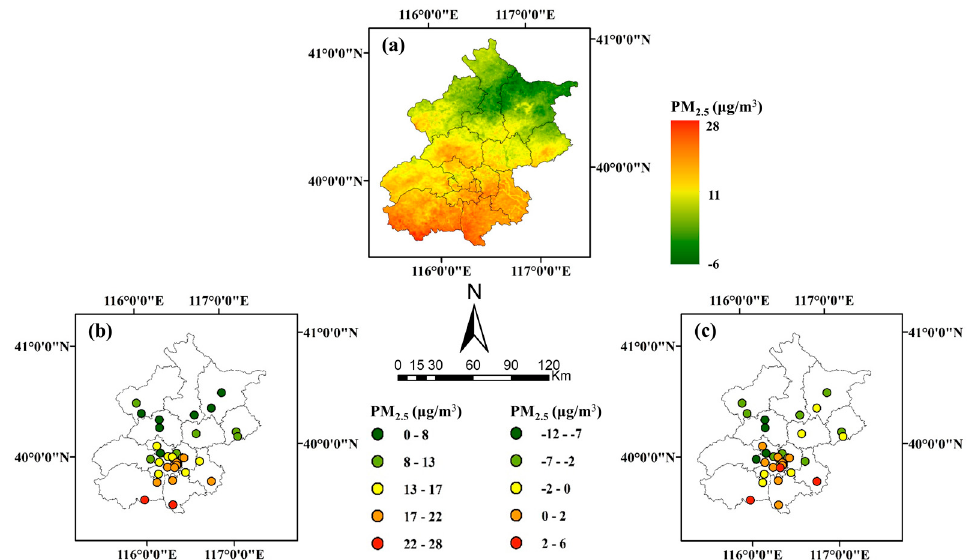
Figure 9. Some annual comparisons. ( a ): Average differences between the GF and the NGF (here, we used the GF minus the NGF). ( b ): Average differences between the true PM 2.5 concentrations and the NGF in PM 2.5 sites (here, we used the true concentrations minus the NGF). ( c ): Average differences between the true PM 2.5 concentrations and the GF in PM 2.5 sites (here, we used the true concentrations minus the GF).